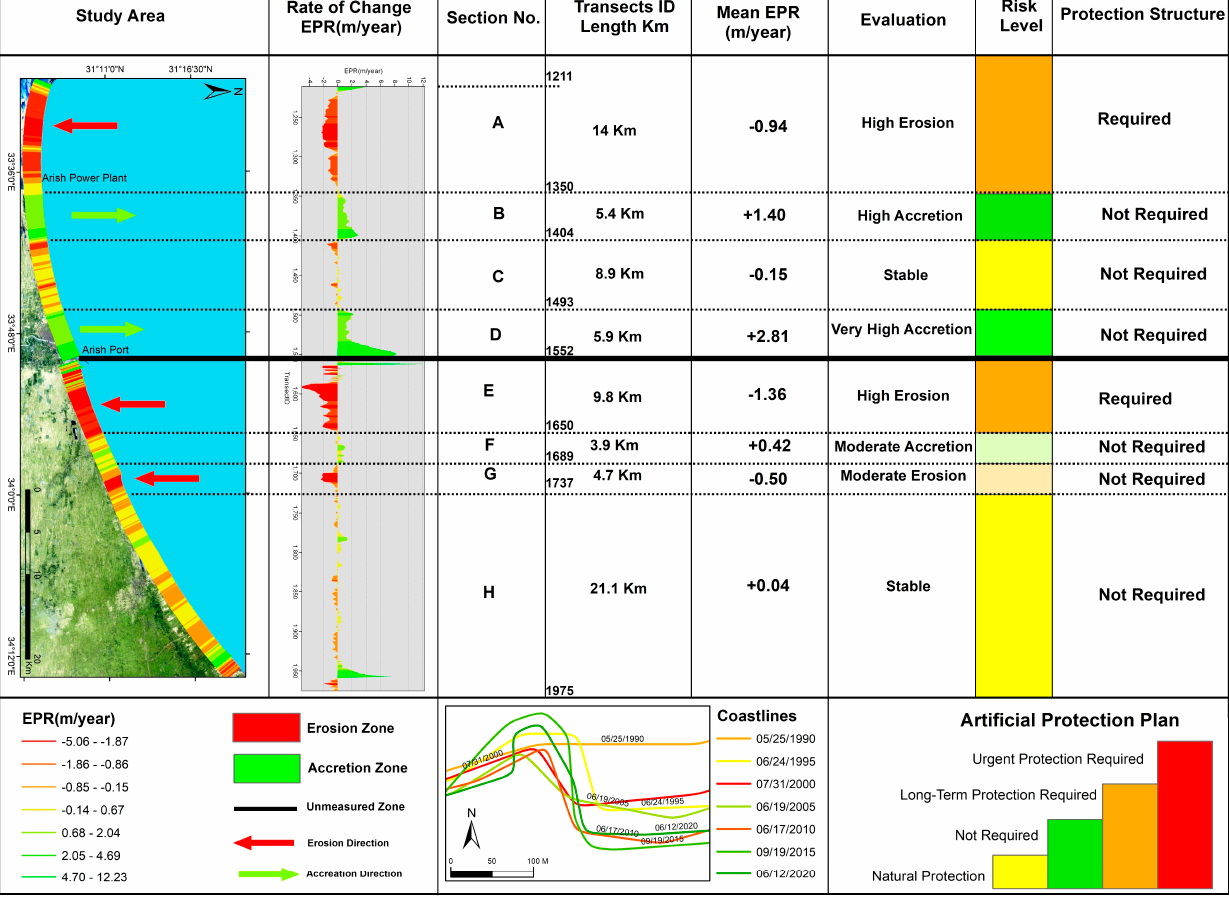
Figure 16. Coastal erosion management matrix along the Arish Valley Coast between 1990 and